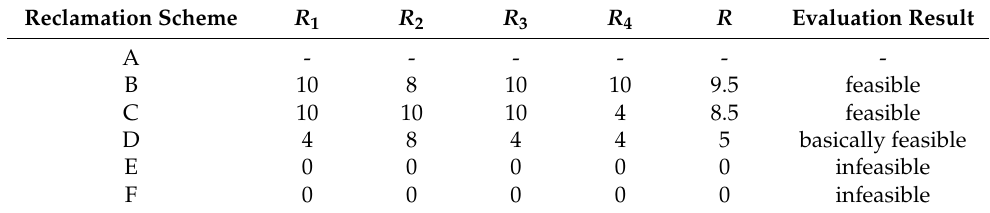
Table 23. Feasibility evaluation of EC (scenario 3).